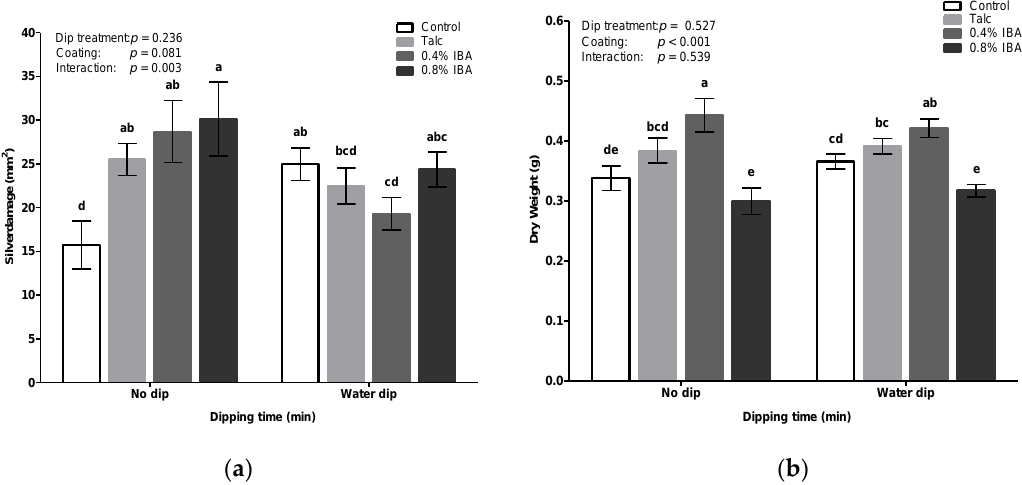
Figure 7. Effect of auxin formulation and duration of dipping on ( a ) thrips-associated feeding damage and ( b ) dry mass. Standardized powder treatments include prewetting of the cutting base in water prior to coating in talc or 0.4% and 0.8% indole-3 butyric acid (IBA). Chrysanthemum cuttings were individually placed in thrips proof cages and were exposed to adult thrips released at rate of 20 thrips per cutting. One week post infestation, silver damage symptoms were visually scored. Data are expressed as damaged leaf area in mm 2 (means ± SEM). Means for water dipping represent pooled cumulative silver damages of three different dipping durations. Different letters denote significant differences among groups as determined by GLM followed by the Fisher’s LSD test ( p < 0.05). The overall effects of dipping treatment, coating and their interaction are indicated in each graph.